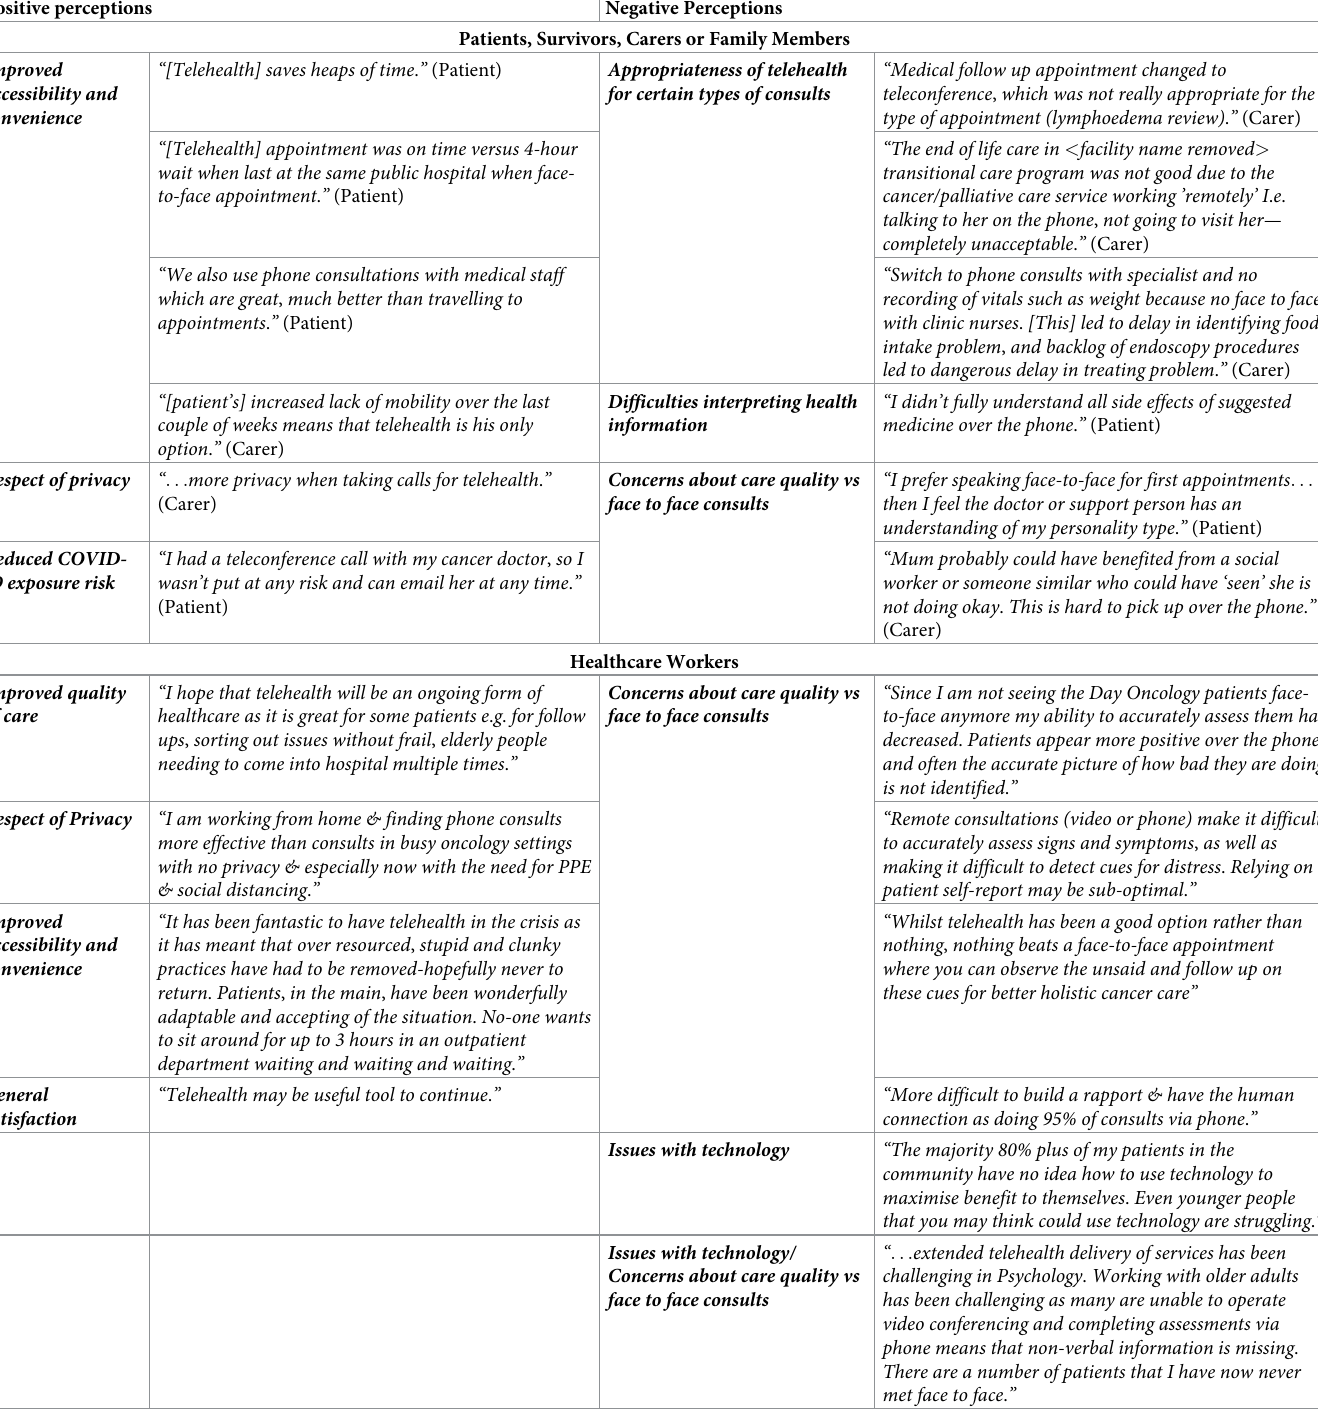
Table 2. Positive and negative perceptions of telehealth reported by those affected by cancer and healthcare